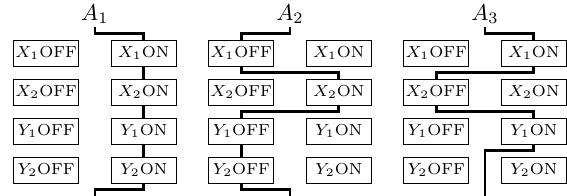
Figure 108. An instance of G 2 .